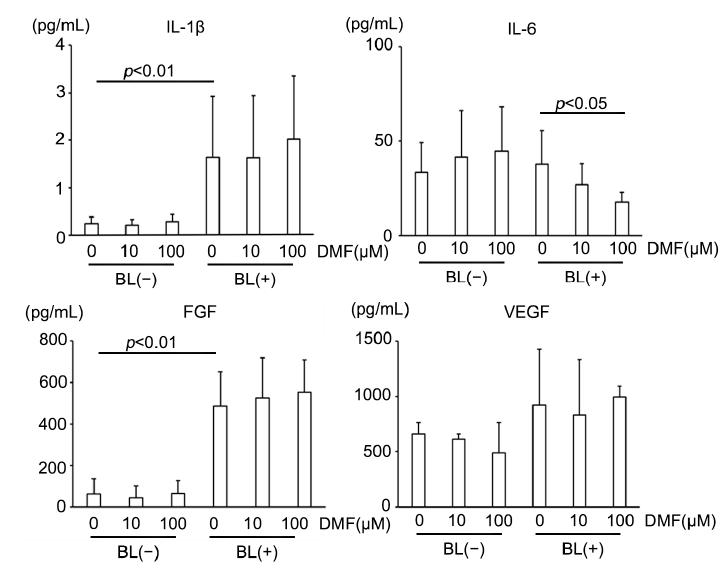
Figure 5. Representative inflammatory cytokine expressions in ARPE-19 cells exposed to blue light (BL). BL strongly increased IL-1 β and FGF expression, which DMF did not alleviate ( n = 10 per group). DMF decreased IL-6 expression ( n = 10 per group). BL did not increase VEGF expression ( n = 10 per group). Statistical analysis was performed using one-way ANOVA, followed by Tukey’s multiple comparisons test where appropriate. DMF = dimethyl fumarate, FGF = fibroblast growth factor, VEGF = vascular endothelial growth factor.